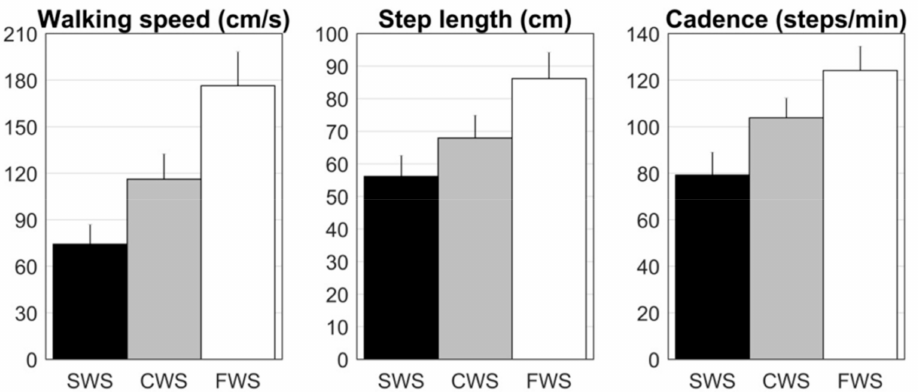
Figure 3. Mean values and between-subjects standard deviations for walking speed, step length and cadence derived from HoloLens data for healthy young adults walking at an instructed slow (SWS, black bars), comfortable (CWS, gray bars) and fast walking speed (FWS, white bars). All spatiotemporal gait parameters di ff ered between walking-speed conditions in to-be-expected directions, demonstrating face